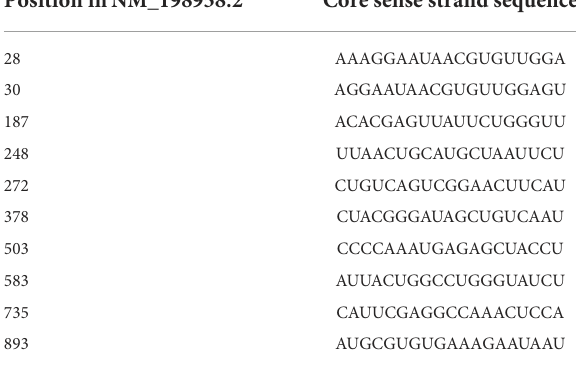
TABLE 1 Sequence of siRNAs and their relative position on Nox3 mouse cDNA. Position in